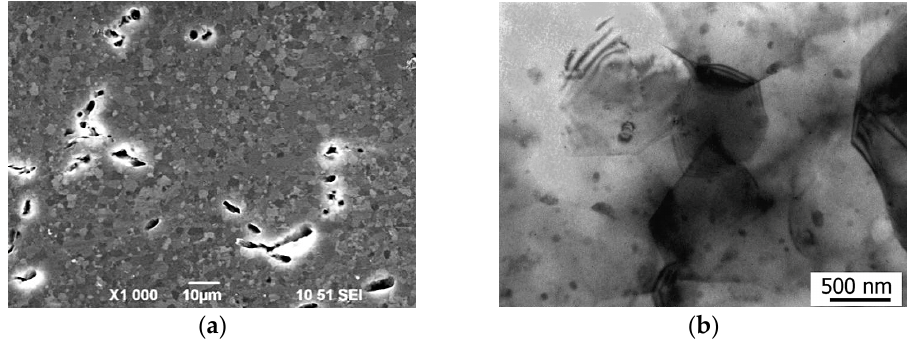
Figure 12. Image of the Mg-1Ca structure after HPT+HT at 250 ◦ C: ( a ) SEM; ( b ) TEM. Table 3. Values of the lattice parameters a and c and the volume fraction of Mg 2 Ca in the Mg-1%Ca alloy in various states.